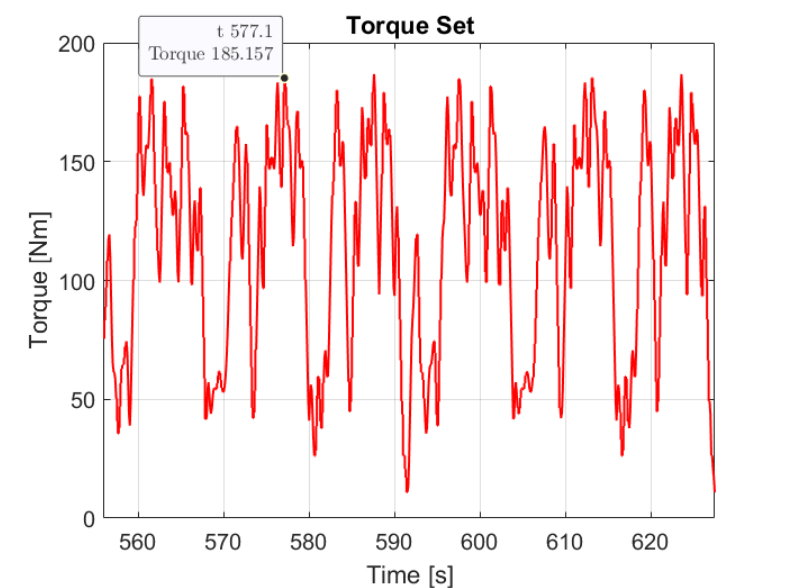
Figure 21. Target torque applied to the generator.